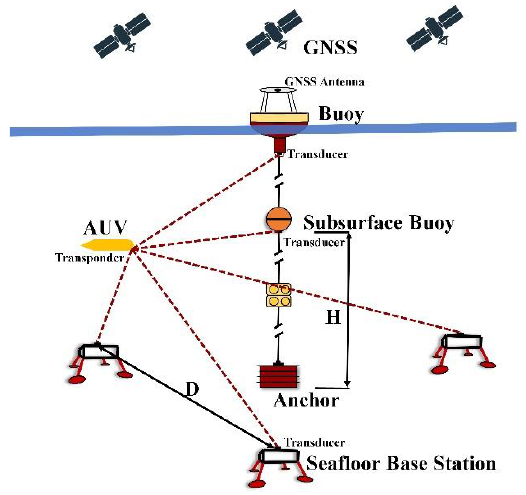
Figure 1. Schematic diagram of the underwater geodetic network configuration and user navigation application. The network consists of a seafloor component and a mooring component.